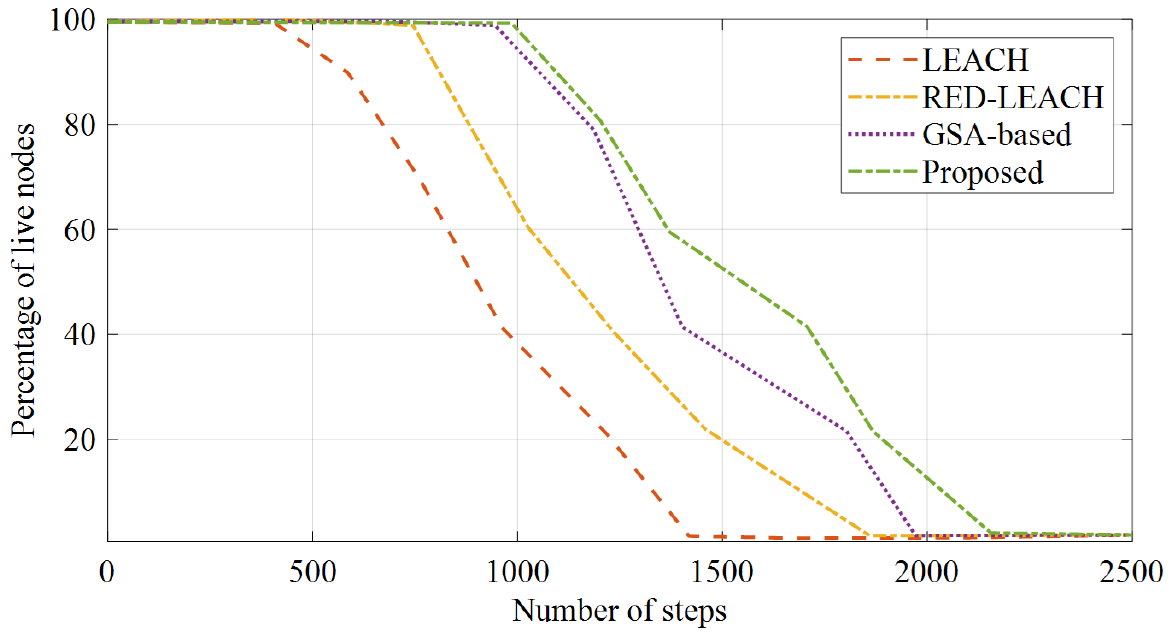
Figure 6. Network lifetime based on the analyzed methods.